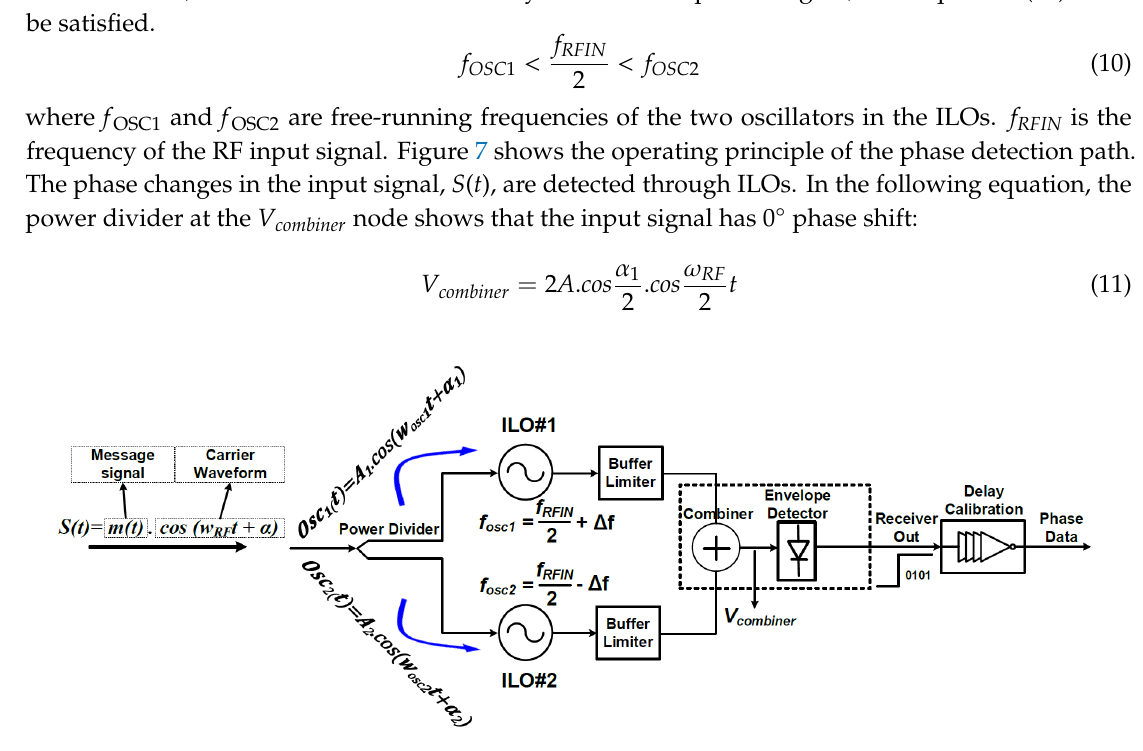
Figure 8. Block diagram of the proposed peak-to-average power ratio (PAPR) path. 321